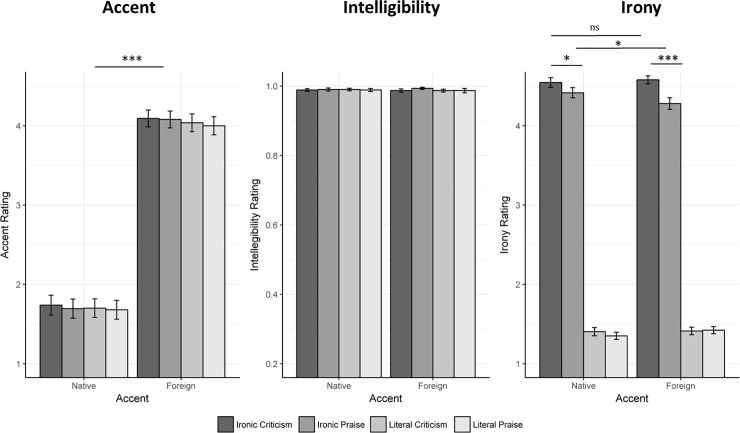
Bar plots of accent, Intelligibility and Irony average scores.Standard error bars are displayed for each experimental condition.